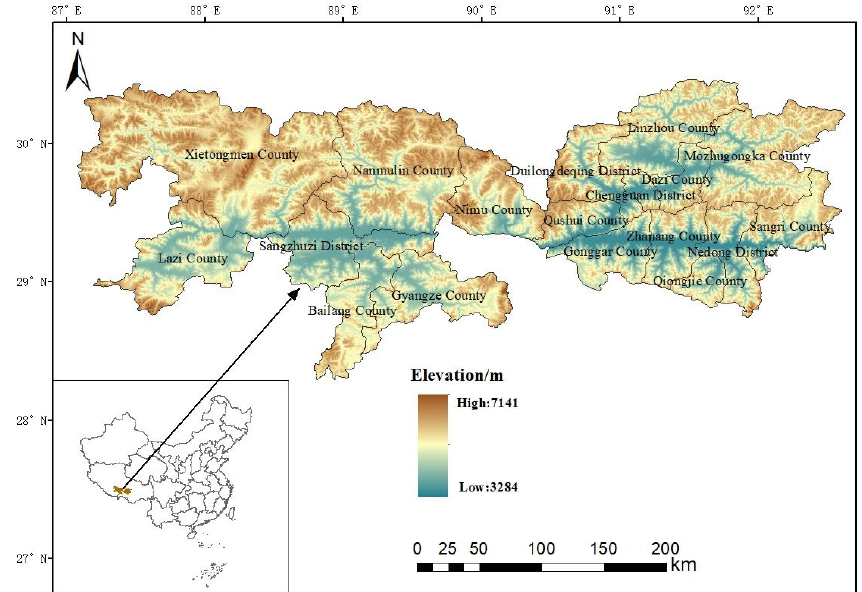
Figure 1. Geographical location of the study area.